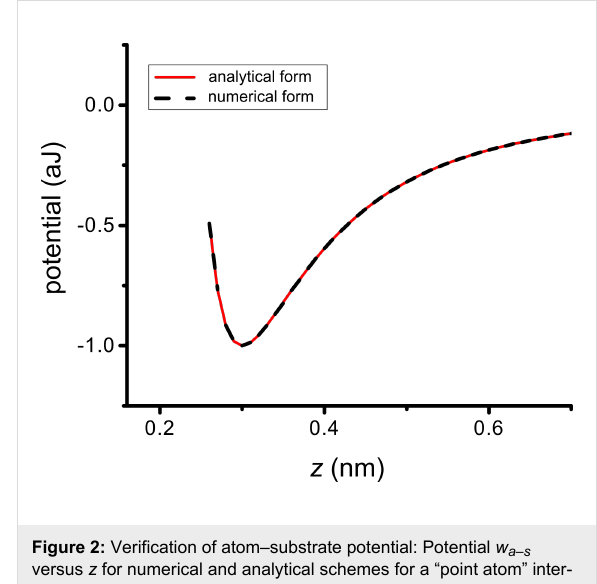
Figure 2: Verification of atom–substrate potential: Potential w a – s versus z for numerical and analytical schemes for a “point atom” inter- acting with a flat surface. The near-perfect overlap of the curves demonstrates the fidelity of the numerical integration scheme.